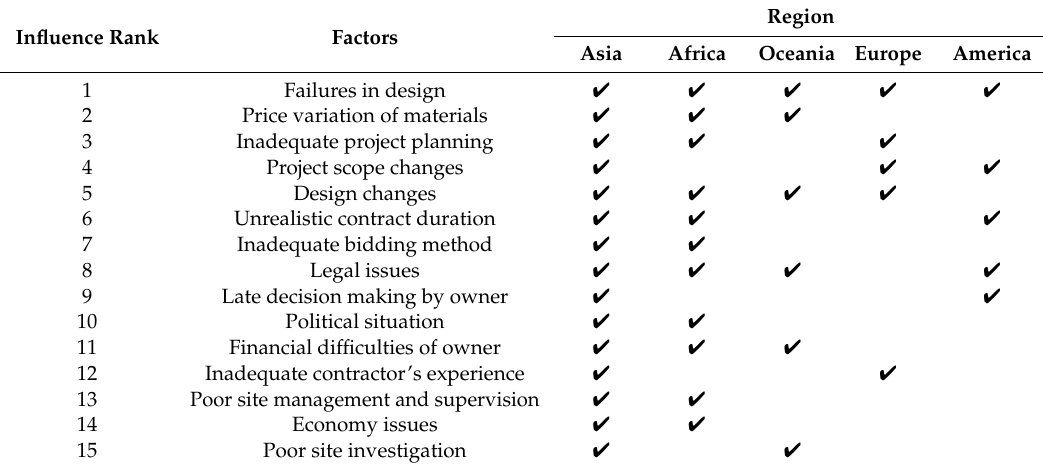
Table 11. Cost overrun factors reported by region.